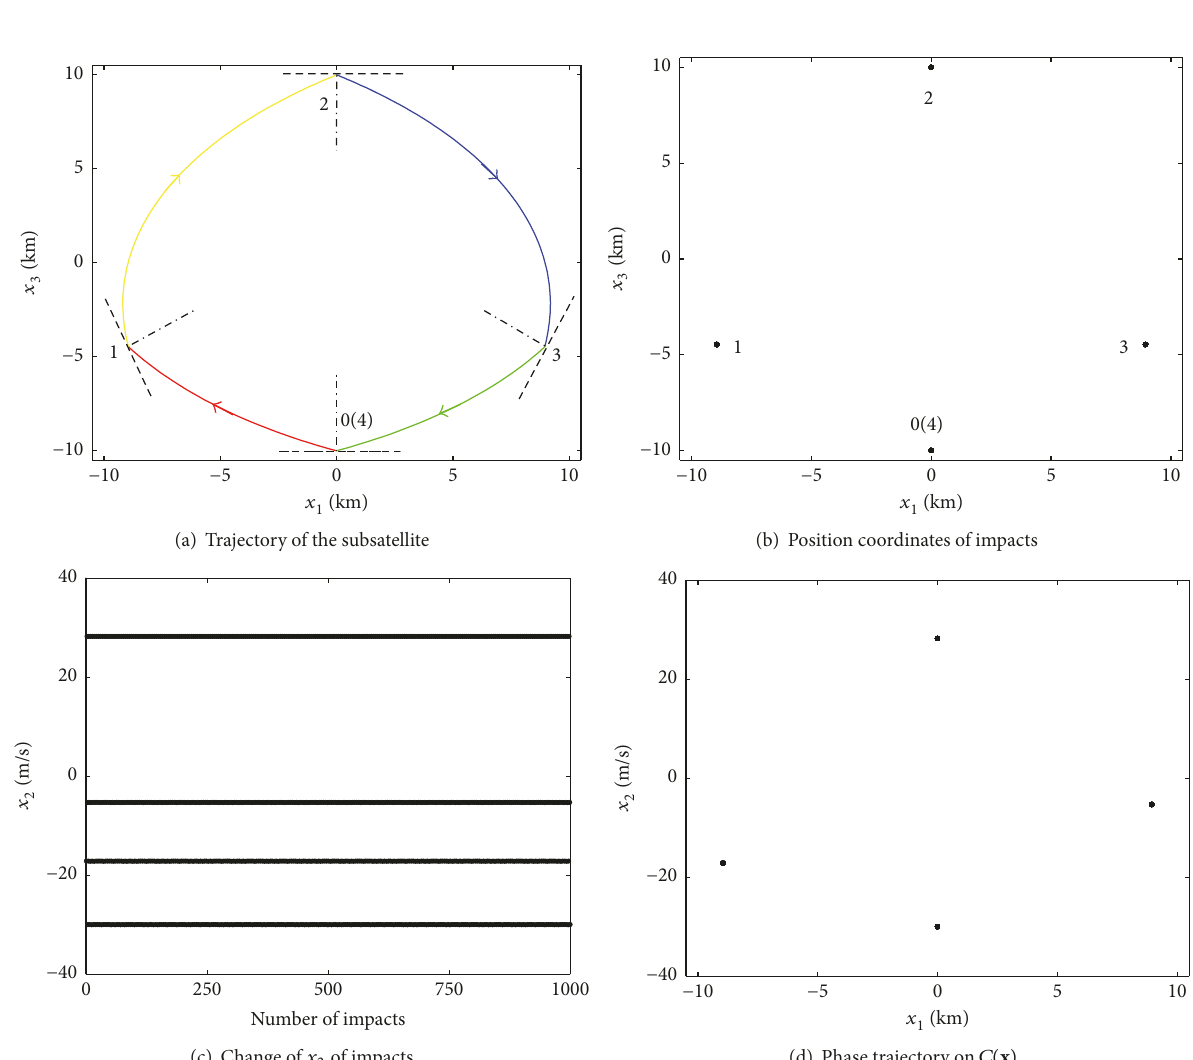
Figure 7: Unstable impact motion.